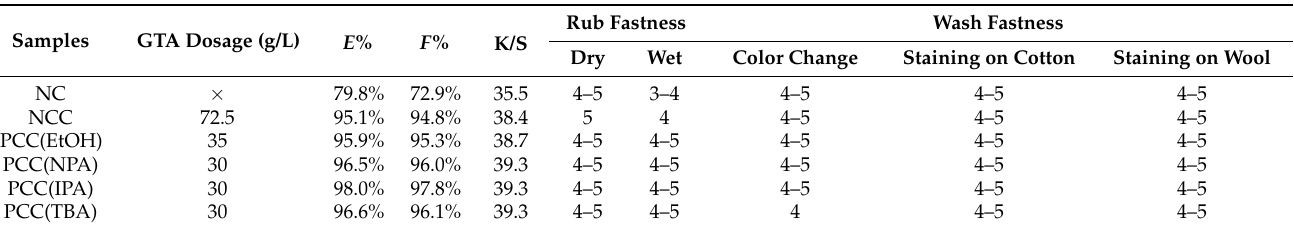
Figure 8. Comparison of hydrophilic properties of different fibers: (a) NC, (b) PC(EtOH-70), (c) PC(NPA-60), (d) NCC, (e) PCC(EtOH), (f) PCC(NPA-60). Table 2. Dye exhaustion, dye fixation, K/S, and color fastness of cotton fibers produced by different dyeing